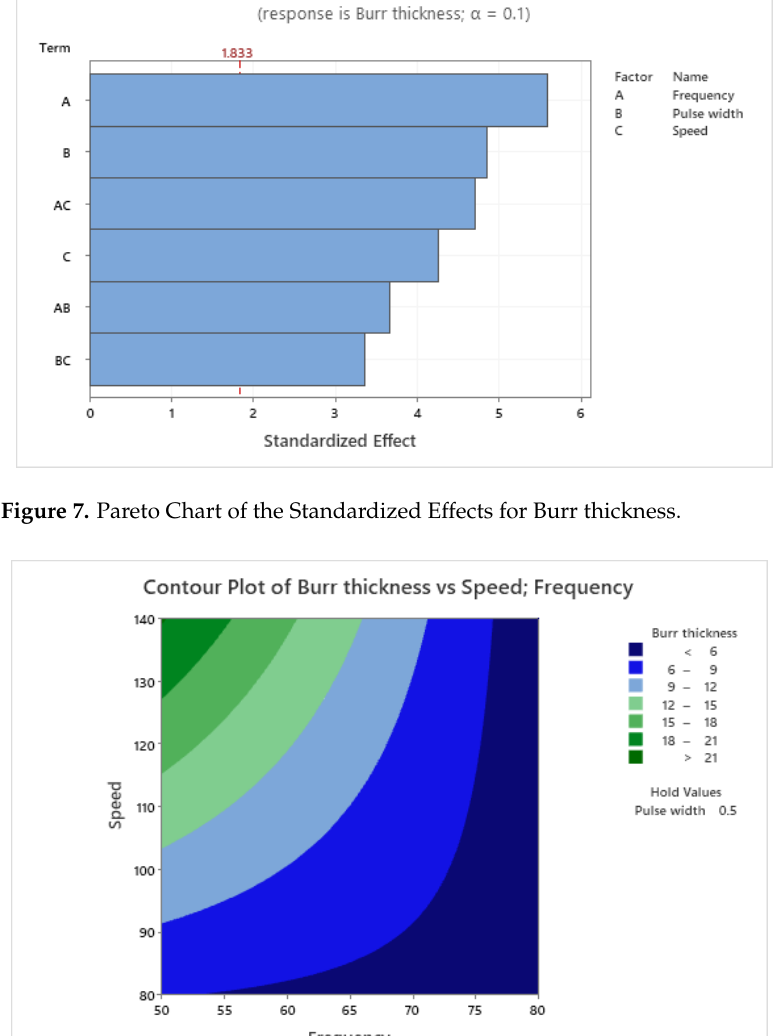
Figure 8. Contour plot of burr thickness error vs. frequency and speed.